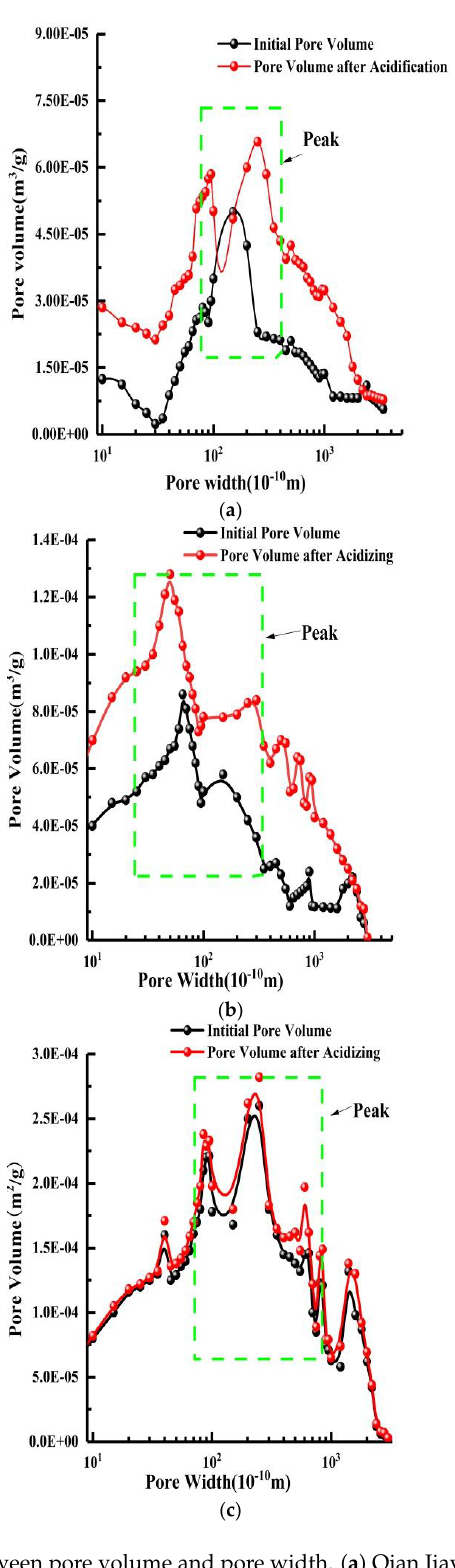
Figure 10. Relationship between pore volume and pore width. ( a ) Qian Jiaying specimens; ( b ) Xiaonan specimens; ( c ) Liujia specimens.